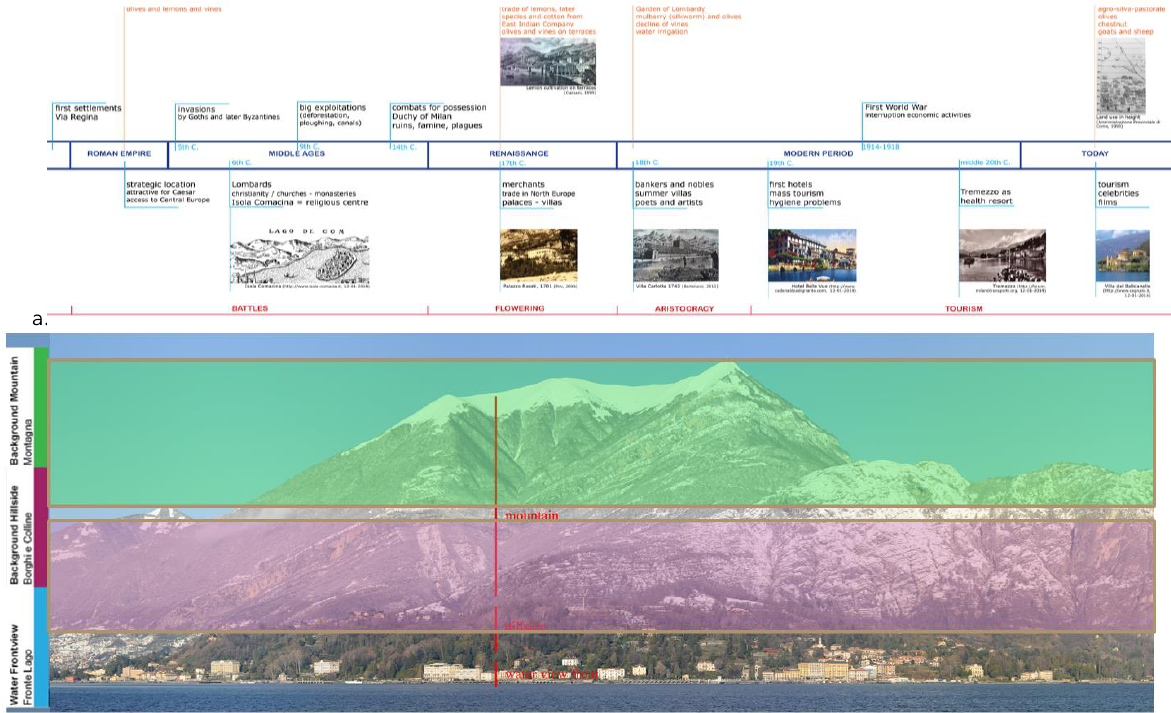
Figure 3. The four main historical phases of the Tremezzina (a) and the arable-wood-pasture landscape three layers framework (b).